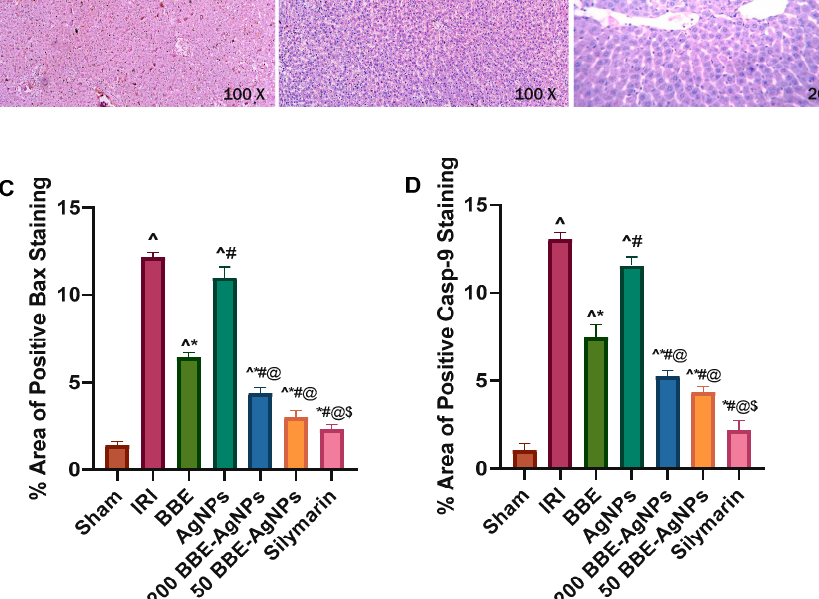
Figure 9. Effect of pretreatment with BBE , AgNPs, 200 or 50 BBE -AgNPs and Silymarin on the on apoptosis of hepatic cells in I/R injured rats. Representative photomicrographs of ( A ) Bax and ( B ) Casp-9 proteins immunohistochemical staining indicates expression of Bax and Cleaved Caspase-9 in liver tissue. Positive staining was brown. (magnification = 200 × ); ( C ) % area of positive Bax staining; ( D ) % area of positive cleaved caspase ‐ 9 staining Photomicrographs represent Sham, IRI, BBE , AgNPs, 200 BEE ‐ AgNPs, 50 BBE ‐ AgNPs and Silymarin. values are expressed as means of 6 animals ± SEM. Data were analyzed using one ‐ way ANOVA followed by Tukey’s Multiple Com ‐ parisons Test; p < 0.05. As compared with (^) Sham, (*) IRI, (#) BBE , (@) AgNPs and ($) 200